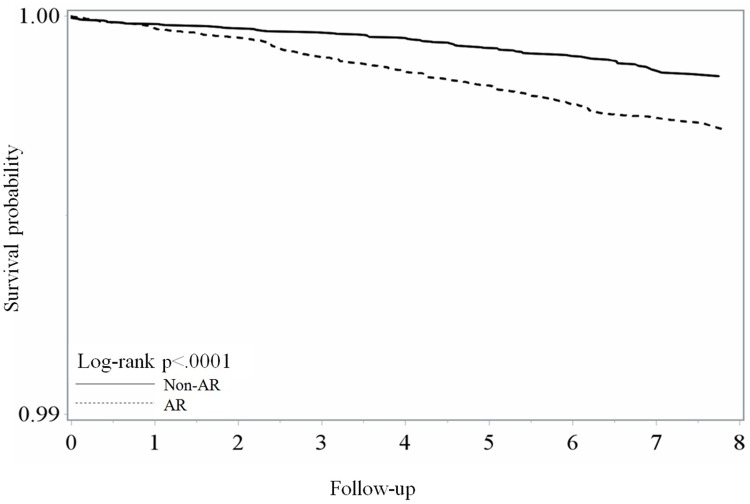
Kaplan-Meier model for estimating dental trauma-free allergic rhinitis patients and non-allergic rhinitis patients.